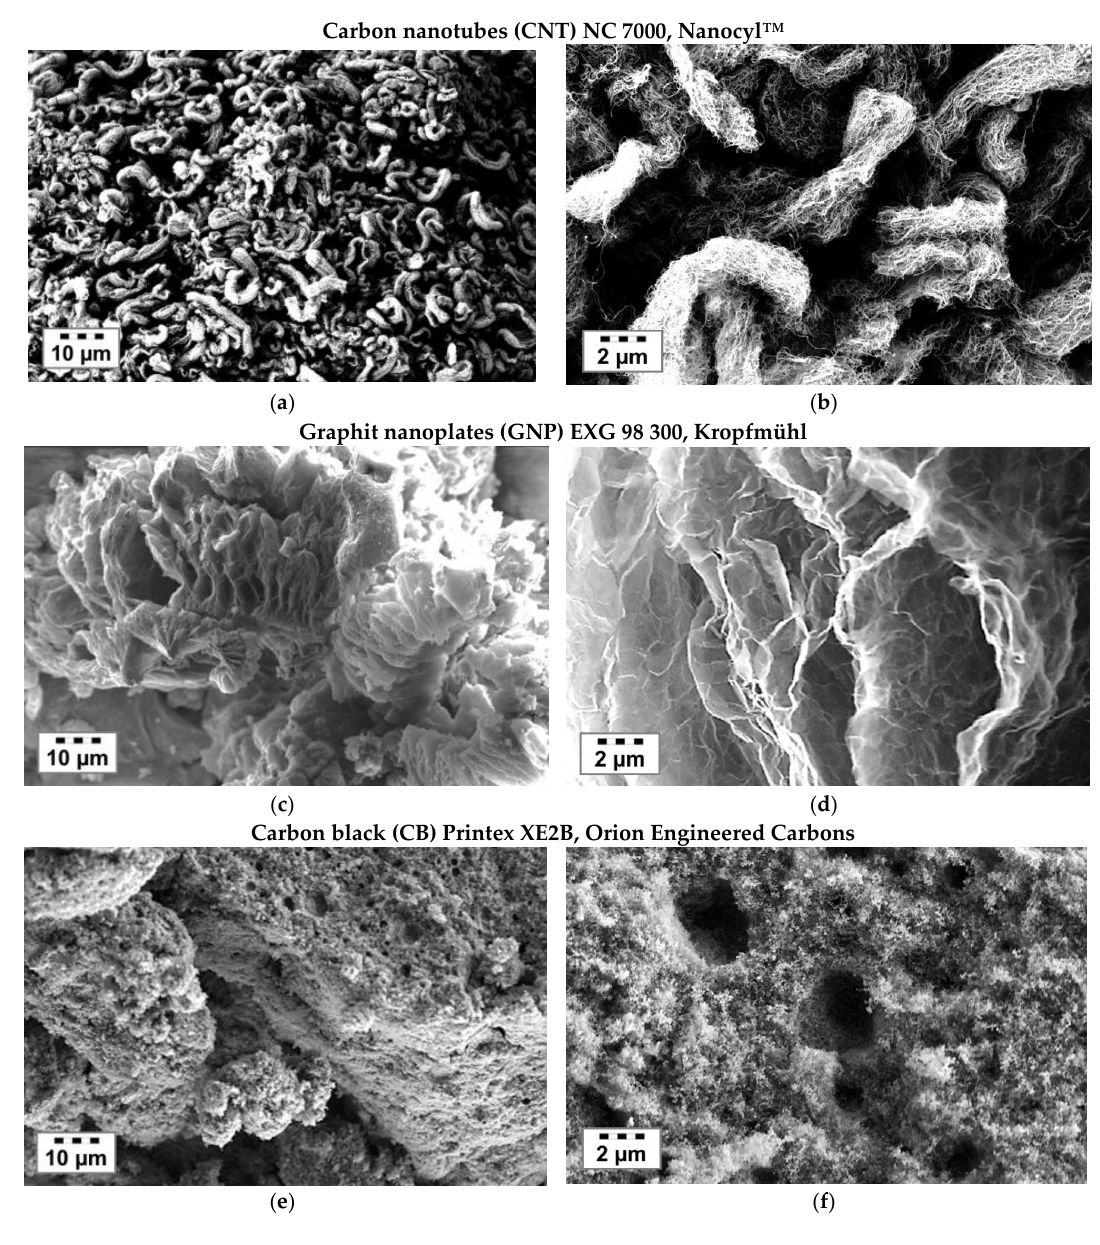
Figure 1. SEM images of different as-received commercially available carbon filler. ( a , b ) Multiwall Carbon nanotubes (NC 7000, Nanocyl™); ( c , d ) Graphit nanoplates (EXG 98 300, Kropfmühl); ( e , f ) Carbon black (Printex XE2B, Orion Engineered Carbons).